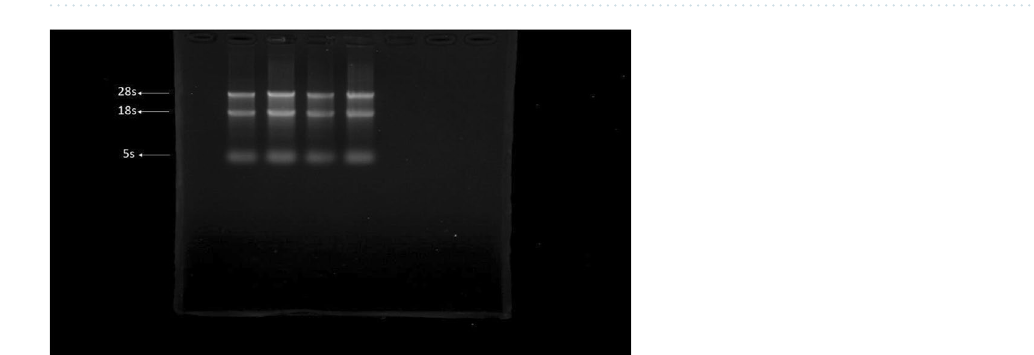
Figure 5. Zeta potential intensity distributions for the native DNA: zeta potential (mean) = − 3.5 mV ( A ), the glycated DNA: − 0.5 mV ( B ), and the glycated DNA with RA: − 1.8 ( C ).